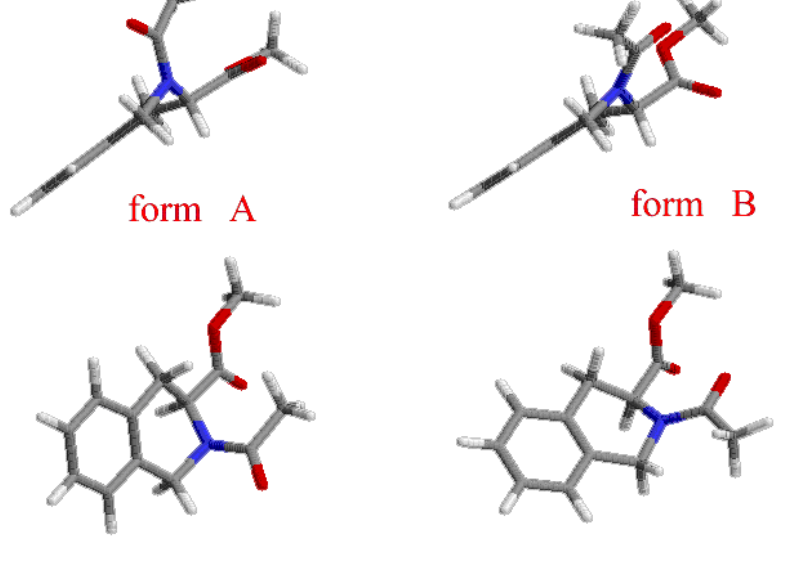
Figure 4. 1 H-NMR spectrum of compound 3a in CDCl